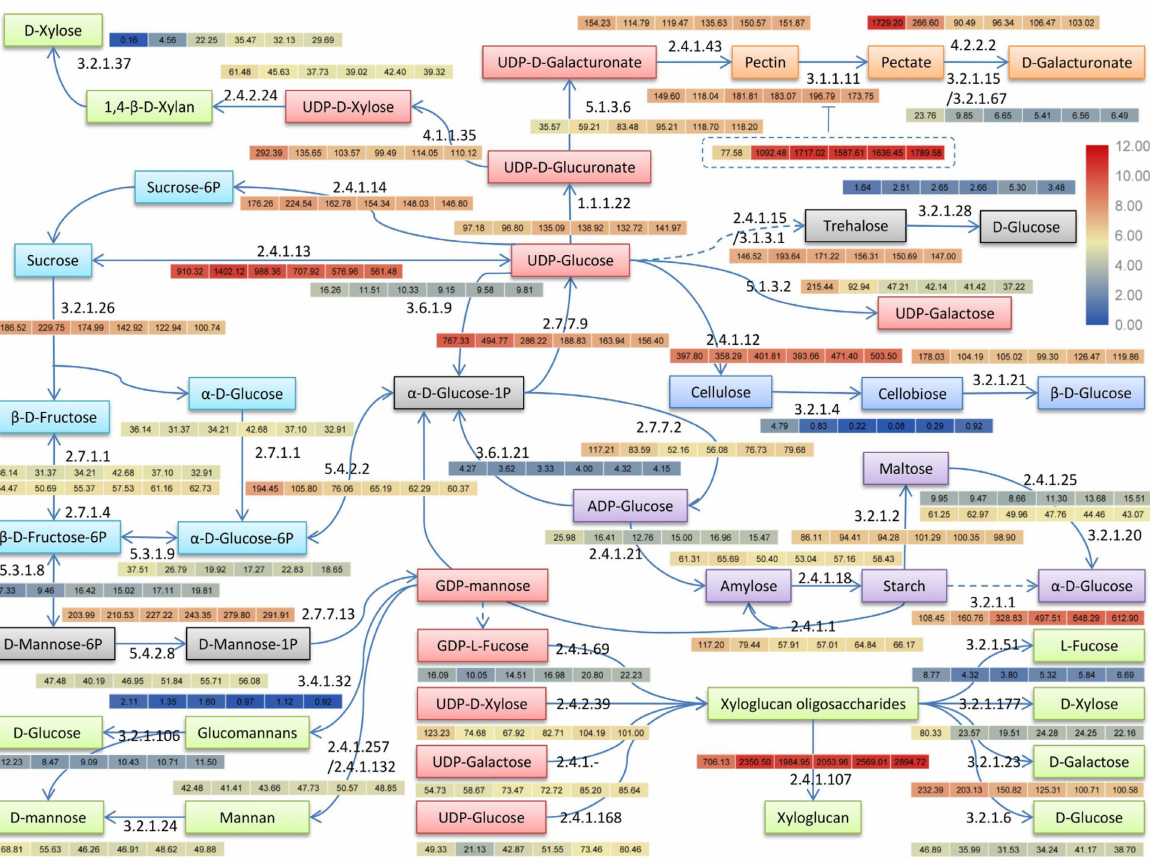
Figure 6. The predicted pathway of major sugars and polysaccharides metabolisms in cold-stored loquat fruits. Red boxes: NDP-sugars; sky blue boxes: sucrose metabolism; purple boxes: starch metabolism; blue boxes: cellulose metabolism; orange boxes: pectin metabolism; green boxes: hemicelluloses metabolisms; gray boxes: other metabolites; dashed box: pectin methylesterase inhibitor. Solid arrow represents the reaction is direct while dashed arrow means there are several reactions between these two metabolites. The numbers next to arrows (i.e., 3.2.1.26) are enzyme codes (Table 3). Dispersive heatmaps with different colors next to enzyme codes exhibited the log 2 reads per kilobase per million reads (RPKM) value of the enzymes and the numbers in different boxes exhibit the corresponding RPKM values. The heatmap boxes from left to right were zero days, seven days, 14 days, 21 days, 28 days, and 35 days,